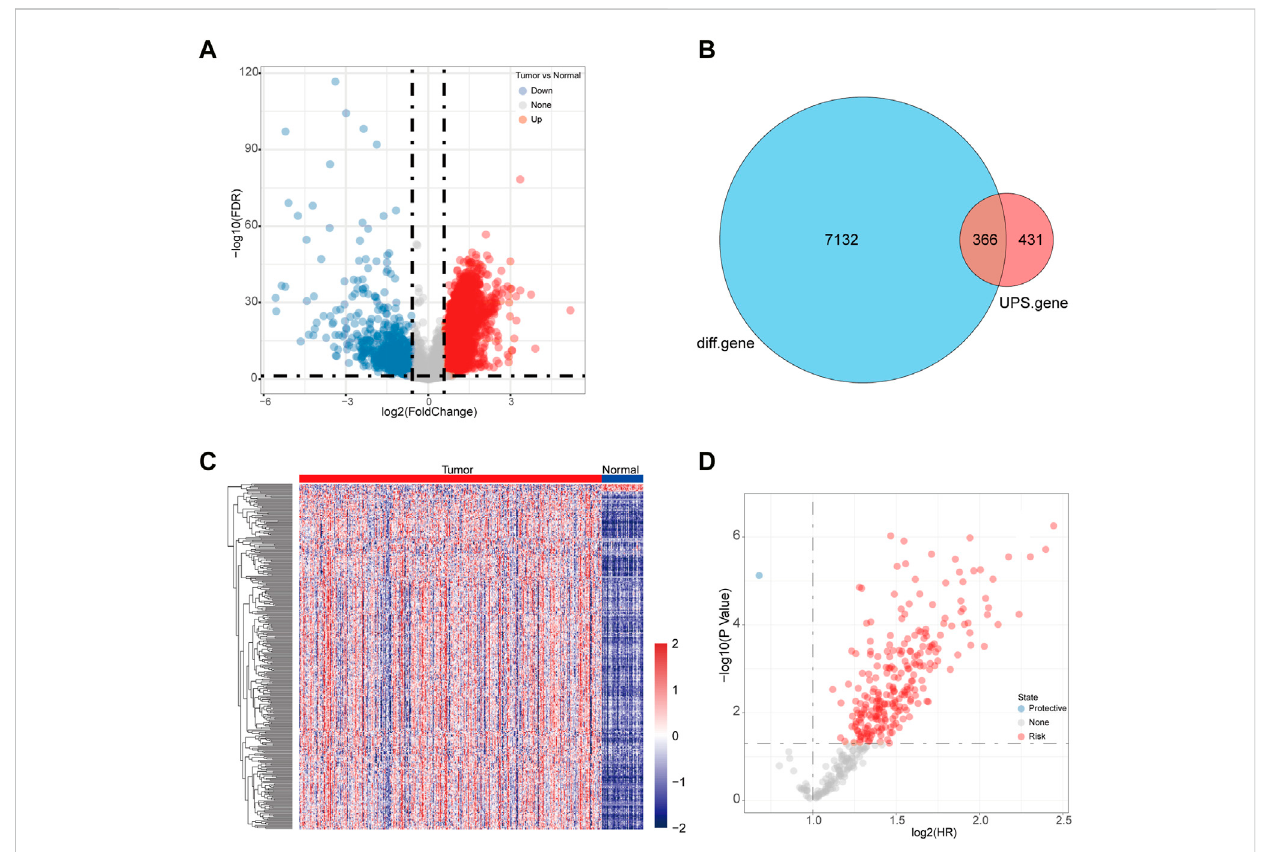
FIGURE 1 Identi fi cation of DEUPS in HCC. (A) Volcano plots displayed 6,682 upregulated and 816 downregulated genes between HCC samples and adjacent normal samples. (B) Venn diagram of overlap analyses for differential genes and UPS genes. (C) Heatmap showing the expression pattern of DEUPS between HCC samples and adjacent normal samples. (D) Scatter plot of univariate Cox regression analyses for screening prognosis-associated